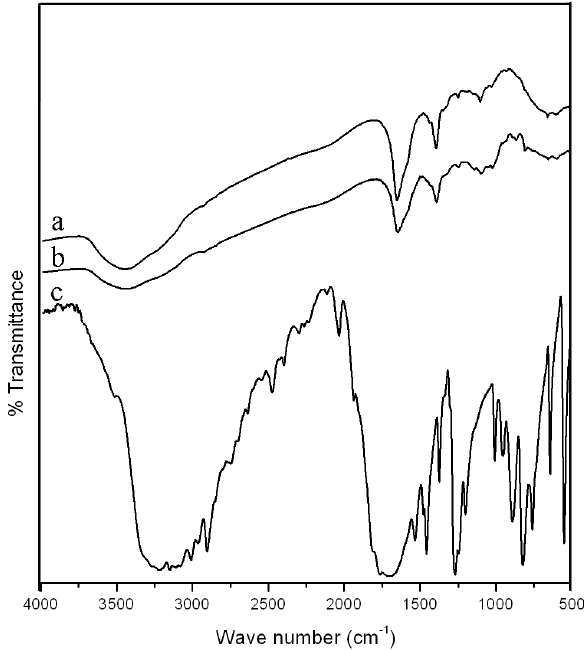
Figure 2. FTIR spectra of PPK hydrogel for P2 formulation: (a) pure PPK hydrogel, (b) 5-FU-PPK hydrogel, and (c) 5-FU.